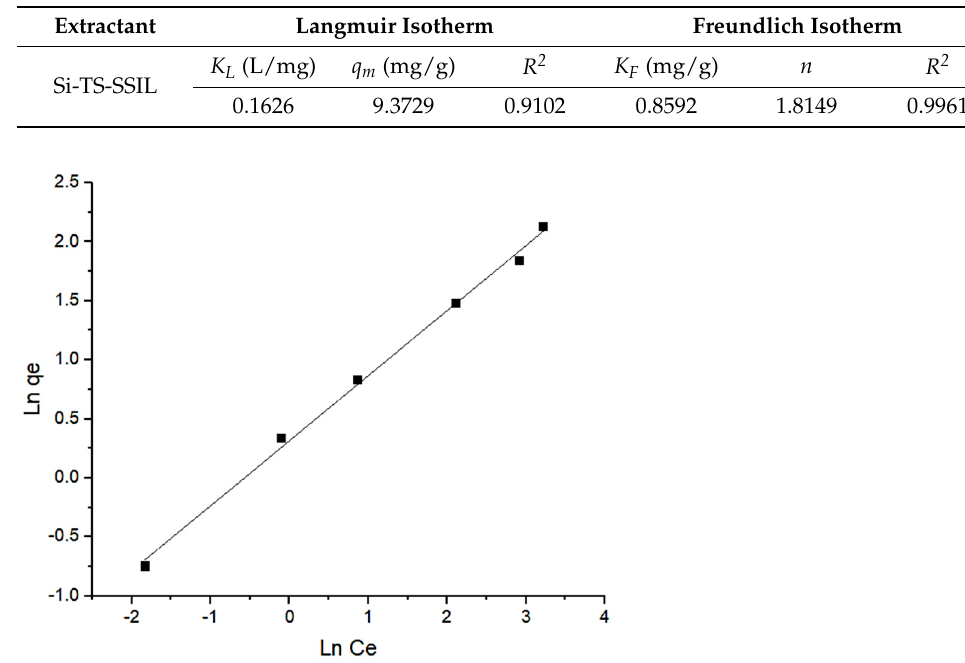
Table 5. Parameters of Langmuir and Freundlich isotherms for the removal of Pb(II) ions by Si-TS-